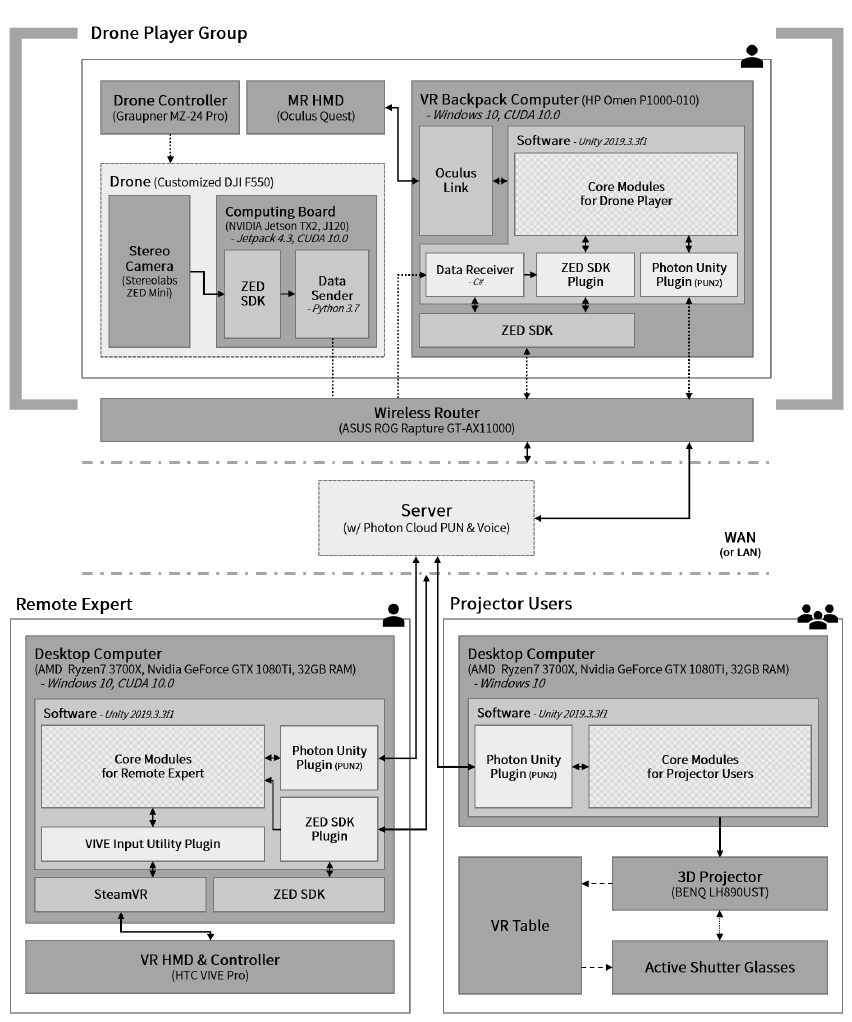
Figure 3. System